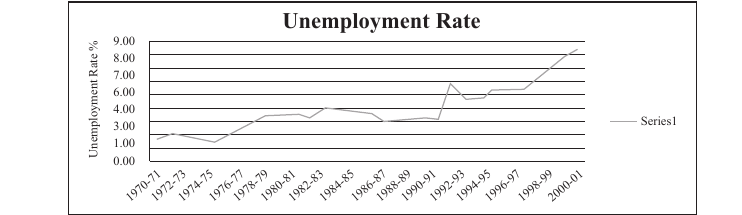
Figure 15. Unemployment